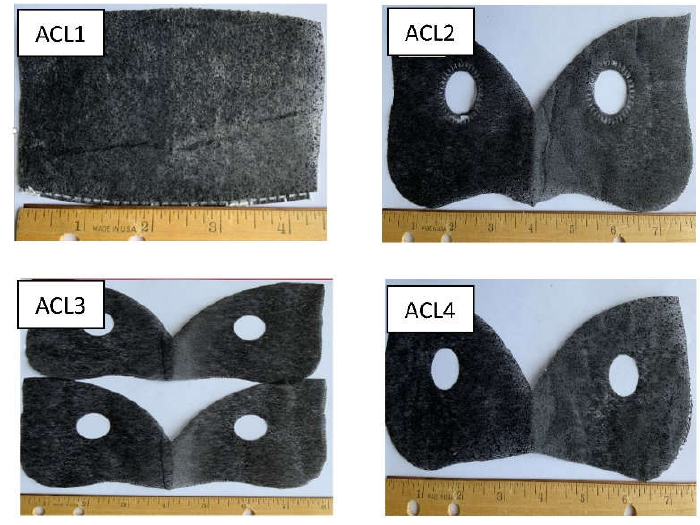
Figure 2. Activated carbon layer/layers of each face mask insert.